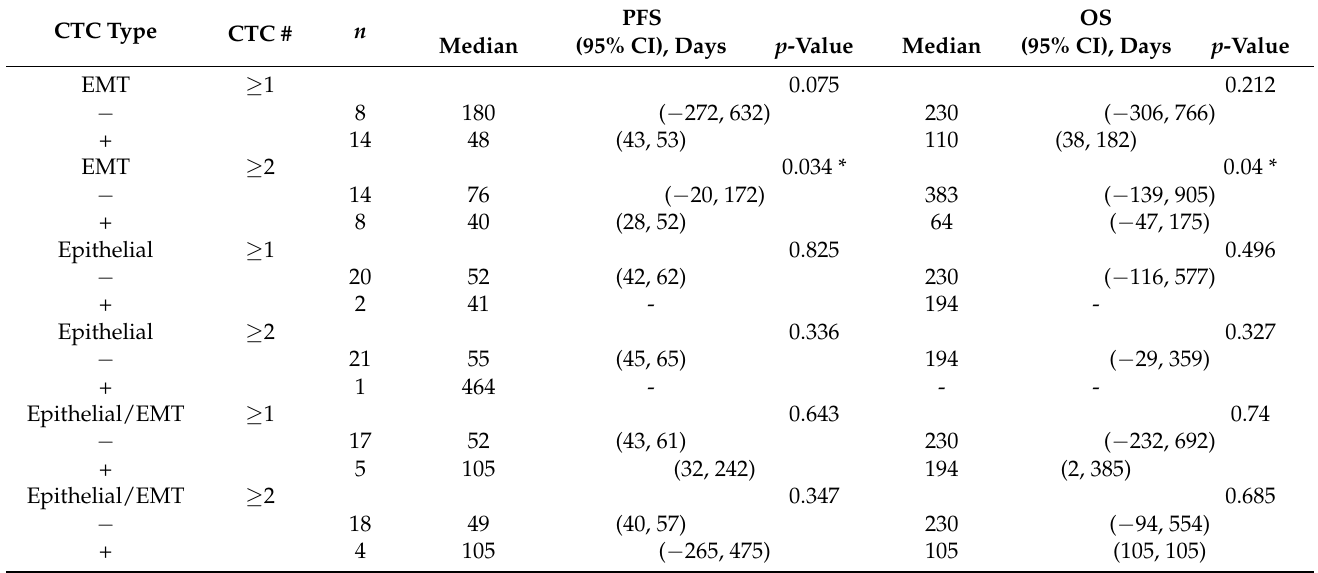
Table 3. PFS and OS in patients with mCRC receiving second- or later-line of